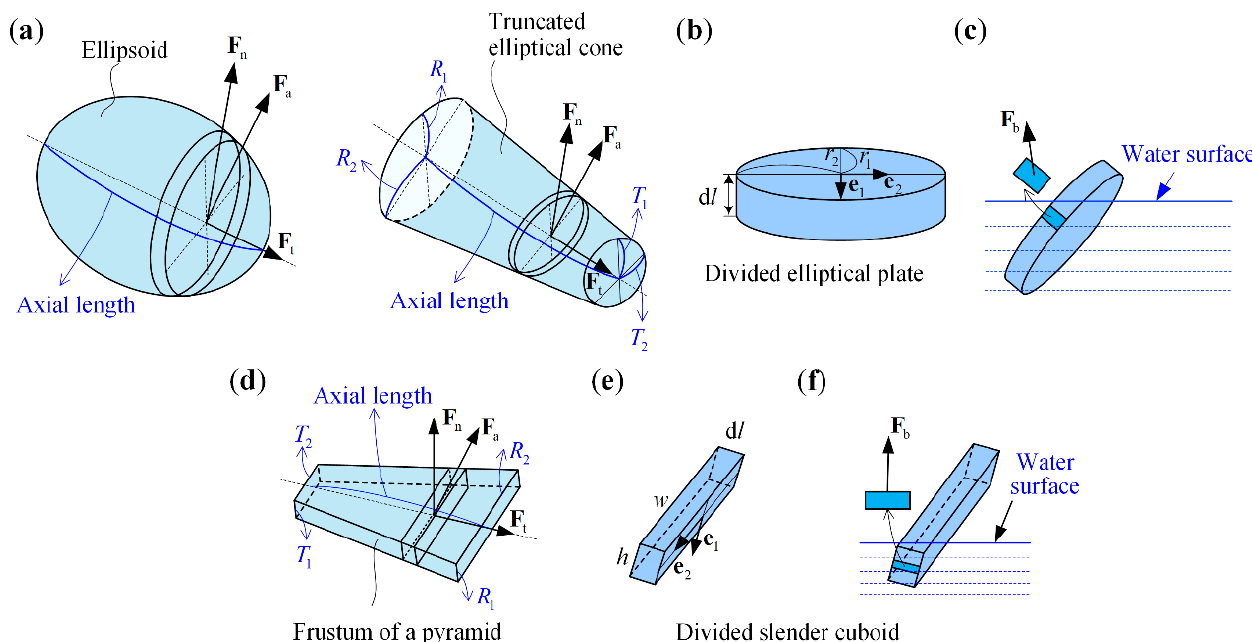
Figure 3. Illustration of the fluid forces acting on the head segment (modeled as an ellipsoid), the limb segments (modeled as truncated elliptical cones), and the hand/foot segments (modeled as frusta of a pyramid). ( a ) The ellipsoid and the truncated elliptical cone, where the divided elliptical plates are denoted. ( b ) Dimensions of a divided elliptical plate. ( c ) The hydraulic pressure force applied on a divided tiny quadrilateral. ( d ) The frustum of a pyramid, where the divided cuboid is denoted. ( e ) Dimensions of a divided slender cuboid. ( f ) The hydraulic pressure force applied on a divided cuboid. For the head and the limbs (excluding the hands and the feet), thin elliptical plates are taken along the longitudinal axis (Figure 3a). The unit vector along the minor and major axes of an elliptical plate are denoted respectively by e 1 and e 2 , and the corresponding radii are r 1 and r 2 , respectively (Figure 3b); the circumference and the thickness of an elliptical plate are denoted by c and d l , respectively. The velocity component of the center of an elliptical plate along the longitudinal axis is represented by v t , and the current velocity component along the longitudinal axis is represented by v ct . With these notations, the tangential drag force F t of an elliptical plate can be expressed as